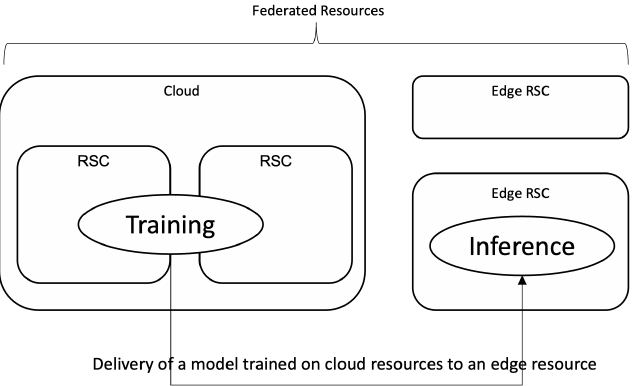
Figure 1. Cloud and Edge resources for a deep learning